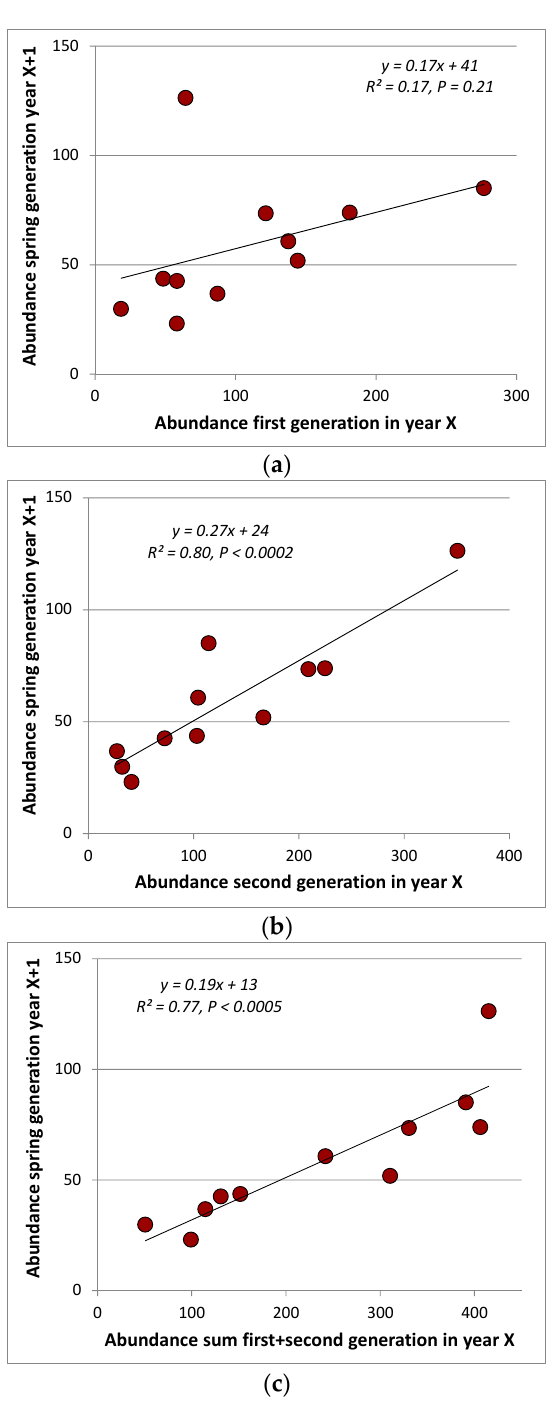
Figure A9. Relation between the abundance of peacock generations in Belgium 2009–2020. ( a ) Correlation between the abundance of the first new generation in year X and the spring generation the following year. ( b ) Correlation between the abundance of the second new generation in year X and the spring generation the following year. ( c ) Correlation between the abundance of the first + second new generation in year X and the spring generation the following year.